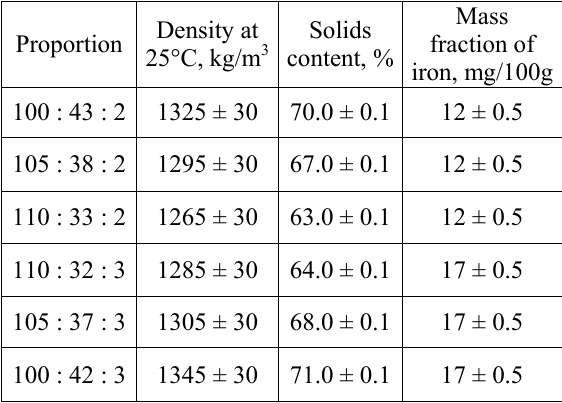
Table 5. Changes in density, solids content, and mass fraction of iron in the bar mixture at varying ingredient proportions Proportion